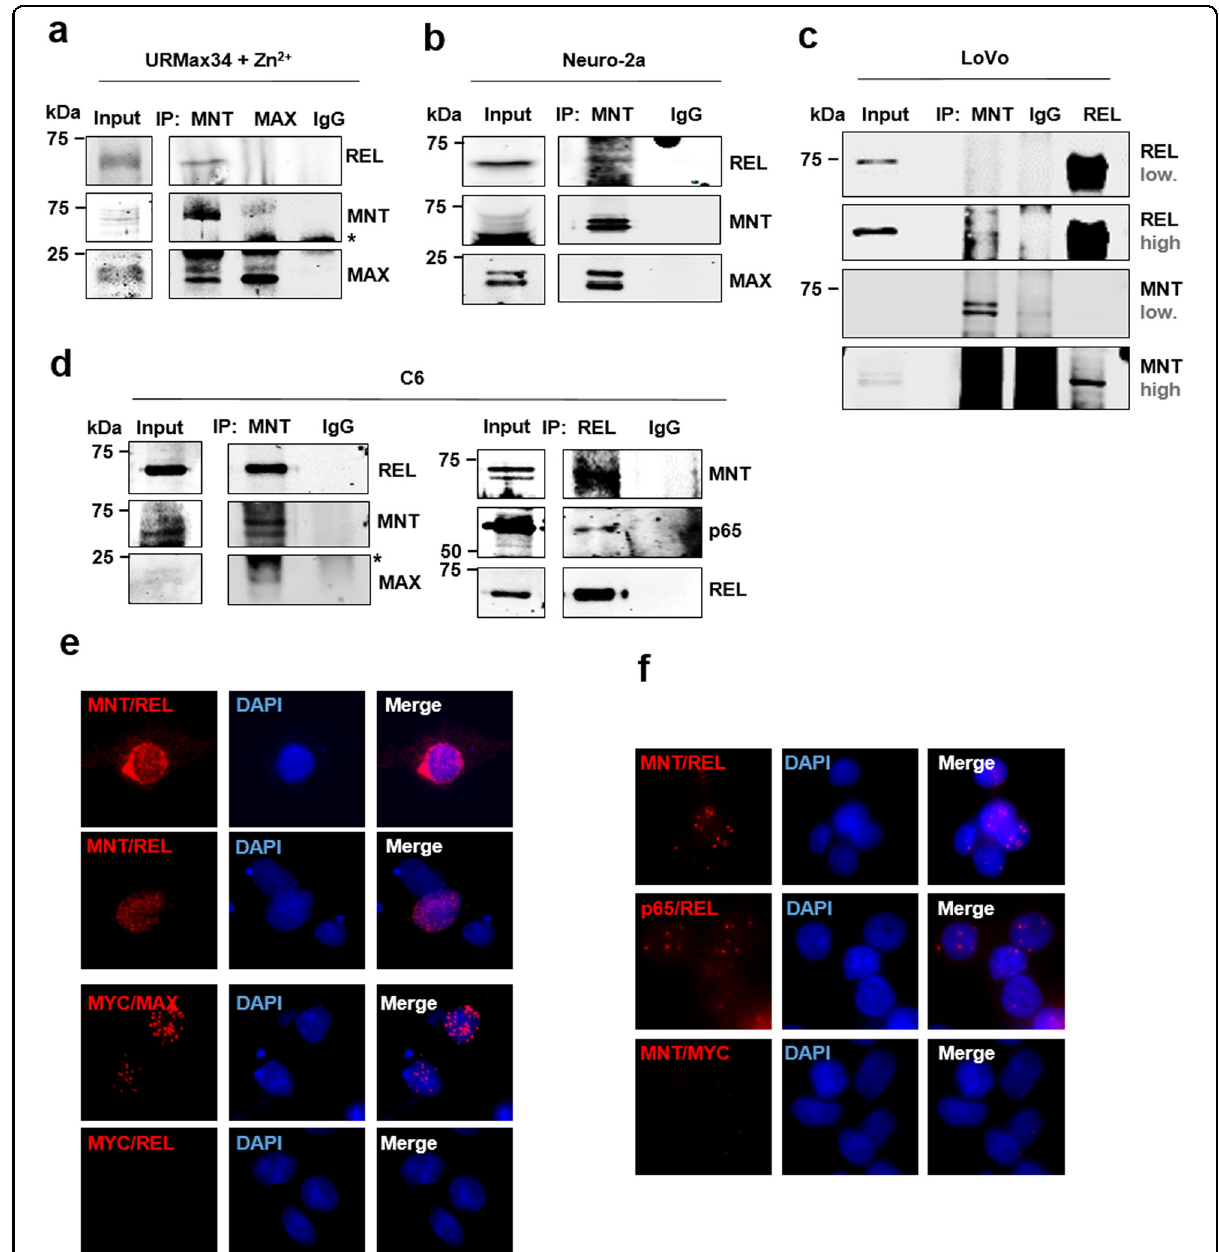
Fig. 2 MNT and REL physically interact. a Co-immunoprecipitation assay with anti-MNT and anti-MAX antibodies in URMax34 cells after Zn 2 +